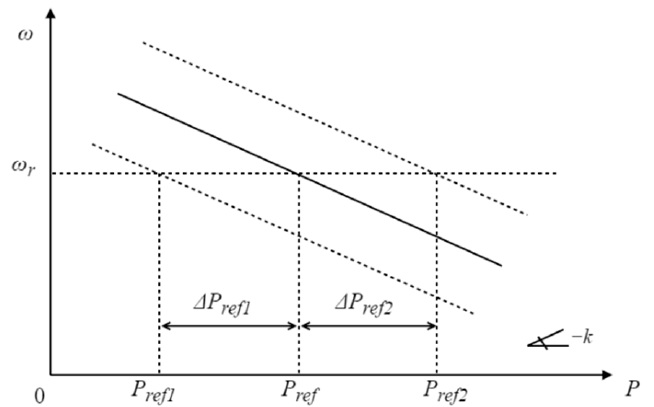
Figure 3. Droop-control curves.